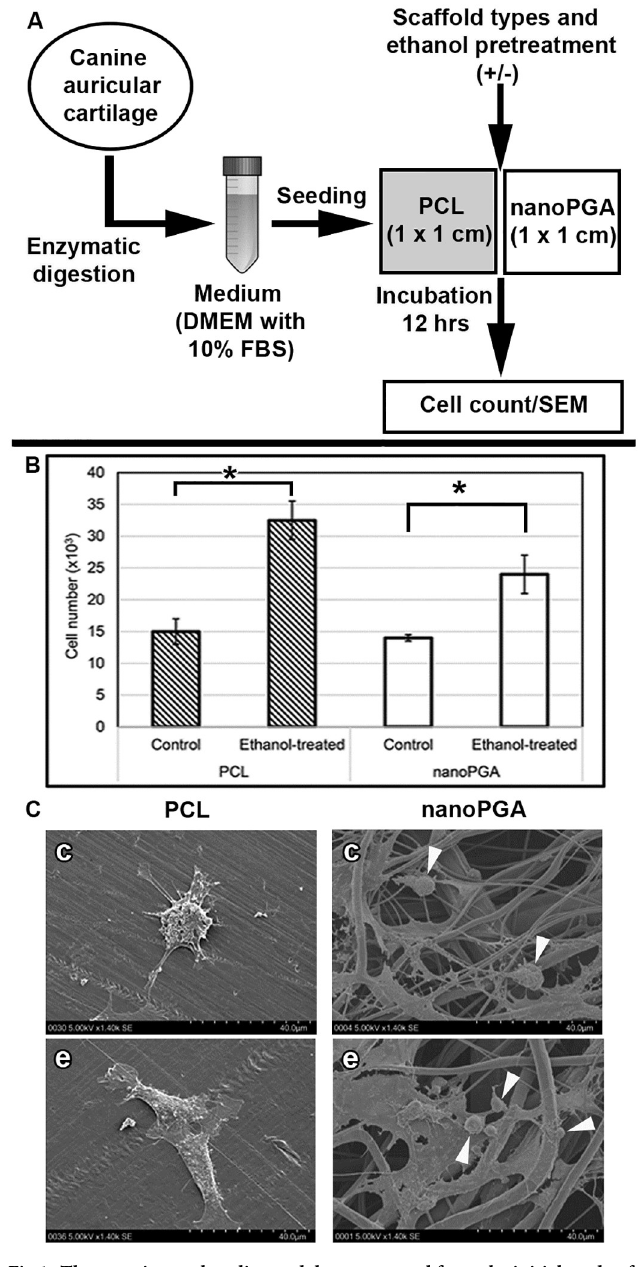
Fig 1. The experimental outline and data generated from the initial study of canine auricular chondrocytes seeded in vitro onto polymer sheets with or without ethanol treatment. (A) A stepwise depiction of the research design from the enzymatic digestion of canine auricular chondrocytes to their seeding onto polymer sheets of either nanoPGA or PCL and final analyses by cell counting and SEM. Six nanoPGA and six PCL sheets received no treatment (control) and an additional six of each of the same sheets were immersed through graded ethanols. (B) Chondrocytes retrieved after trypsinization from polymers were counted following cell seeding on sheets for 12 hr. Statistically significant greater cell counts were found for both ethanol-treated polymer sheets [PCL, n = 4; nanoPGA, n = 4] when compared to their counterpart controls [PCL, n = 4; nanoPGA, n = 4] (p = 0.002 and p = 0.019, respectively). (C) SEM showed flattened cells with prominent filipodia on ethanol-treated (e) PCL sheets (n = 2) and more rounded chondrocytes with limited filipodia visible on control (c) PCL sheets (n = 2). Canine auricular chondrocytes were visible (arrowheads) on nanoPGA sheet fibers with (n = 2) or without (n = 2) ethanol treatment.